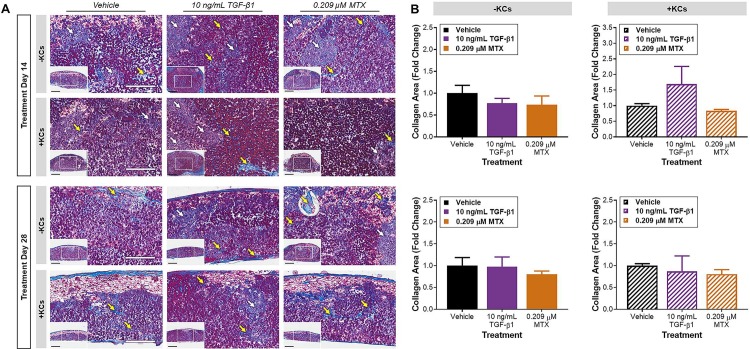
Collagen deposition in tissue sections.(A) Representative photomicrographs of Gomori’s trichrome-stained tissue sections at treatment day 14 and 28. White arrows denote diffuse areas of collagen deposition and yellow arrows denote thicker collagen fibers. Inset indicates area used for quantification. Scale bar = 300 μm, inset scale bar = 75 μm. (B) Fold change collagen relative to model-matched, vehicle-treated control. Data represent the mean of the fold change + SEM at each timepoint (n = 2).